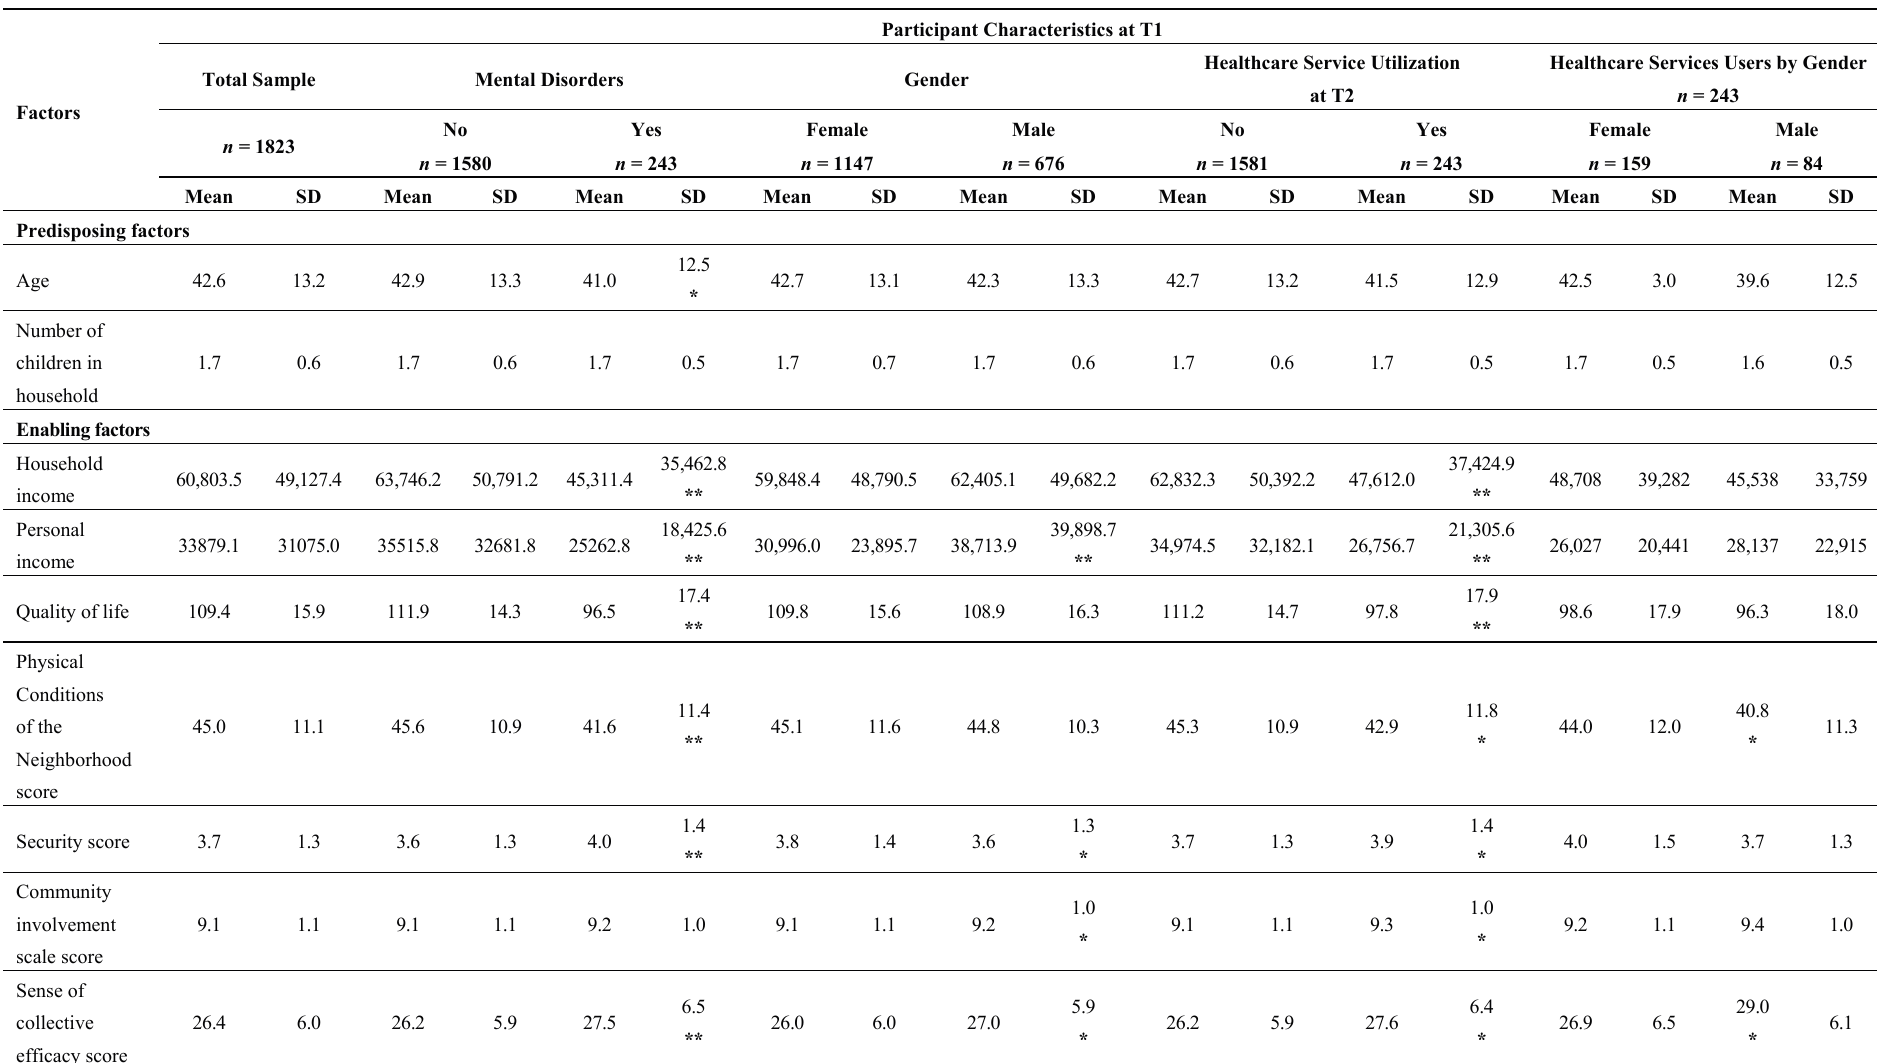
Table 3. Participant characteristic by mental health status, gender and healthcare service utilization: continuous